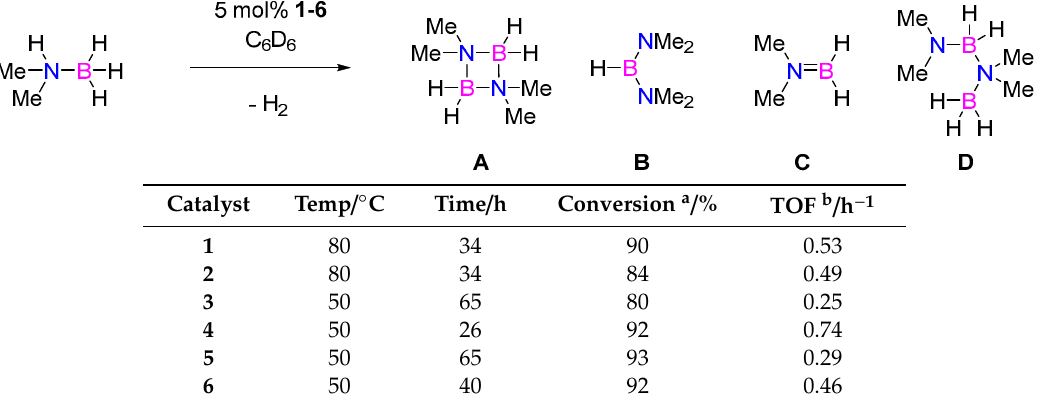
Table 1. Dehydrocoupling of Me 2 NHBH 3 with 5 mol % Al(III) hydride catalysts ( 1 – 6 ).